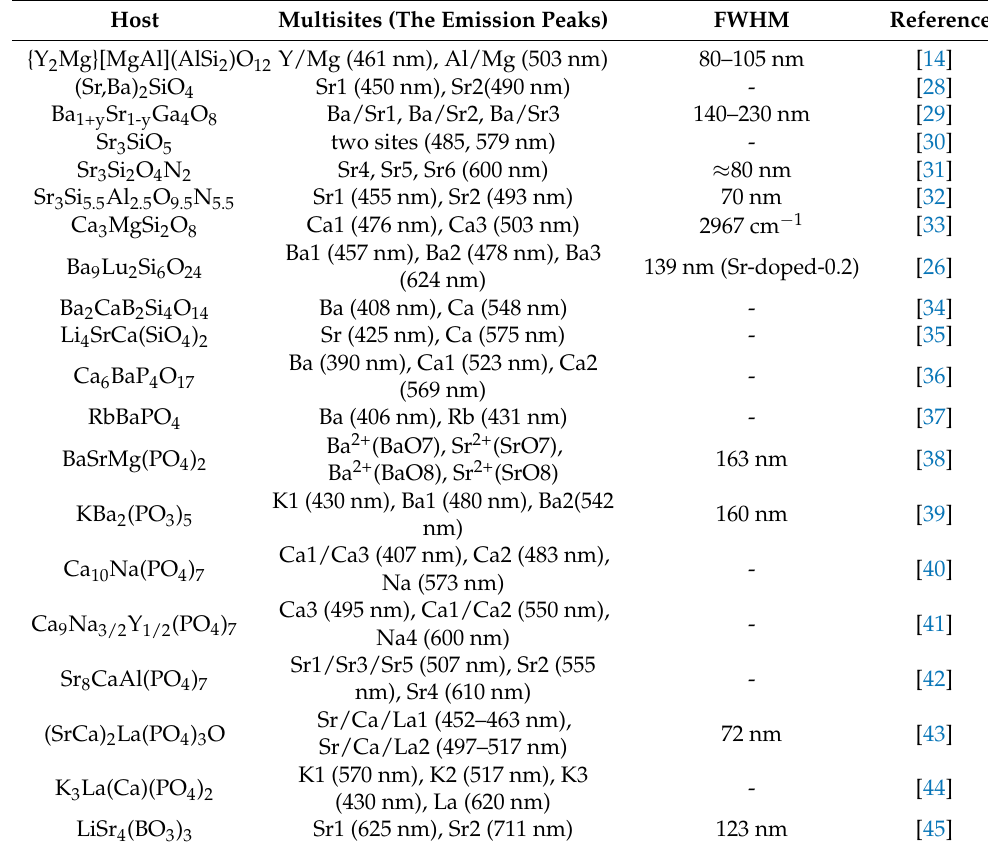
Table 1. Summary of structural and luminescent information for some Eu 2+ -doped multi-site phosphors. Host Multisites (The Emission Peaks)